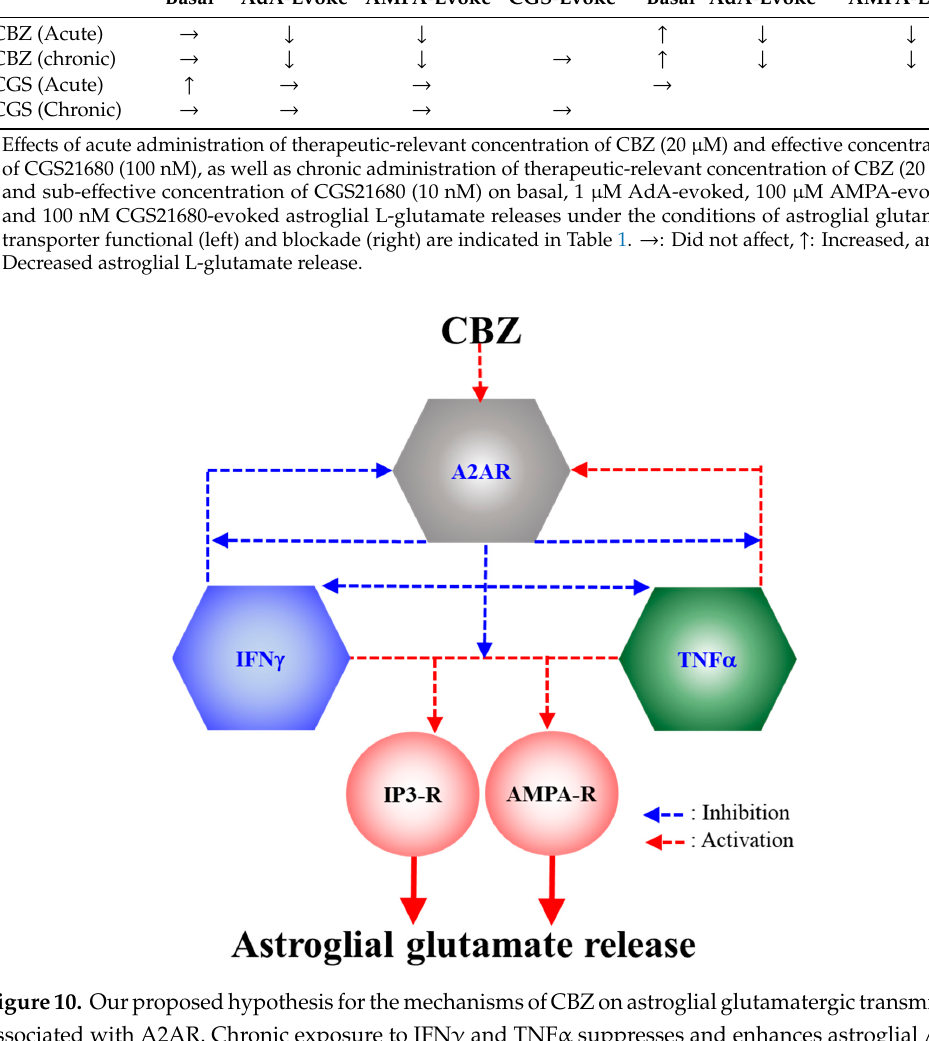
Int. J. Mol. Sci. 2019 , 20 , x Table2: Effects of CBZ and CGS21680 on Astroglial L-Glutamate Release after Chronic Cytokine